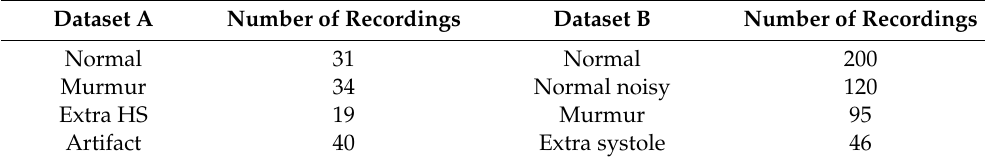
Table 3. Database of heart sounds: Pascal Challenge. HS: heart sound.